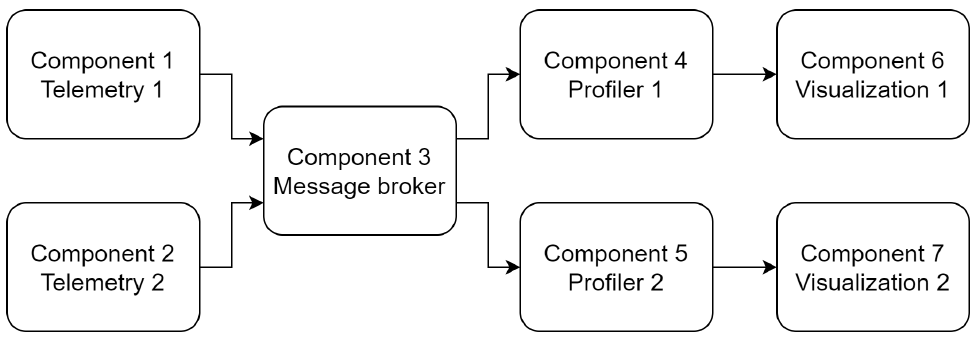
Figure 9. Speed profiling application.